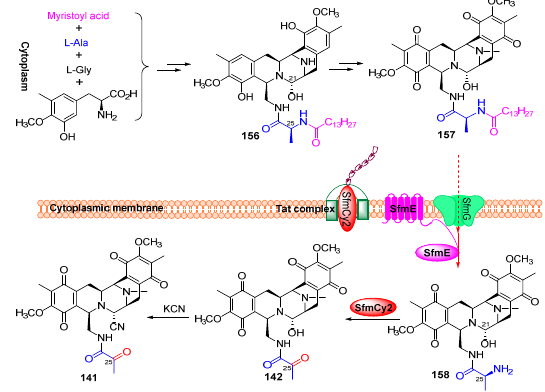
Figure 20. Post-modification of